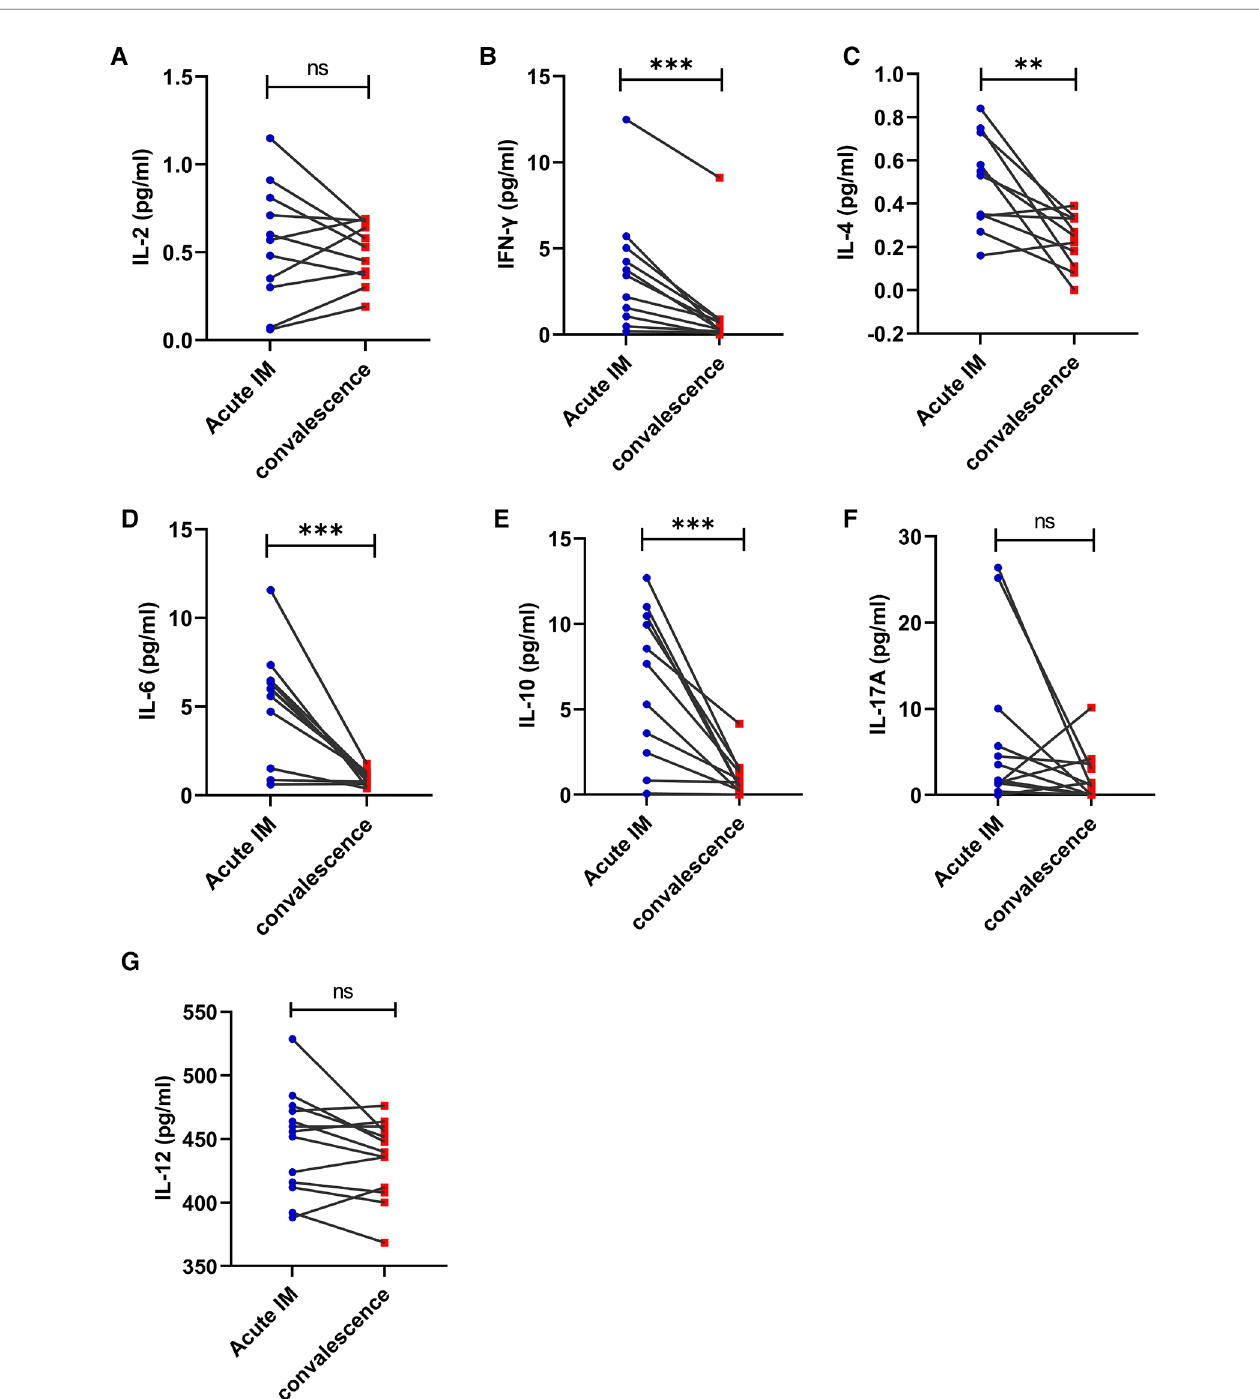
FIGURE 7 Kinetic analysis of Th1, Th2, and Th17 related cytokines and IL-12 during different phases of EBV-infected IM disease. The serum levels of cytokine IL-2 ( A ), IFN- γ ( B ), IL-4 ( C ), IL-6 ( D ), IL-10 ( E ), IL-17A ( F ), and IL-12 ( G ) were analyzed by CBA at the acute and early convalescent phases of IM. ** P <0.01, *** P